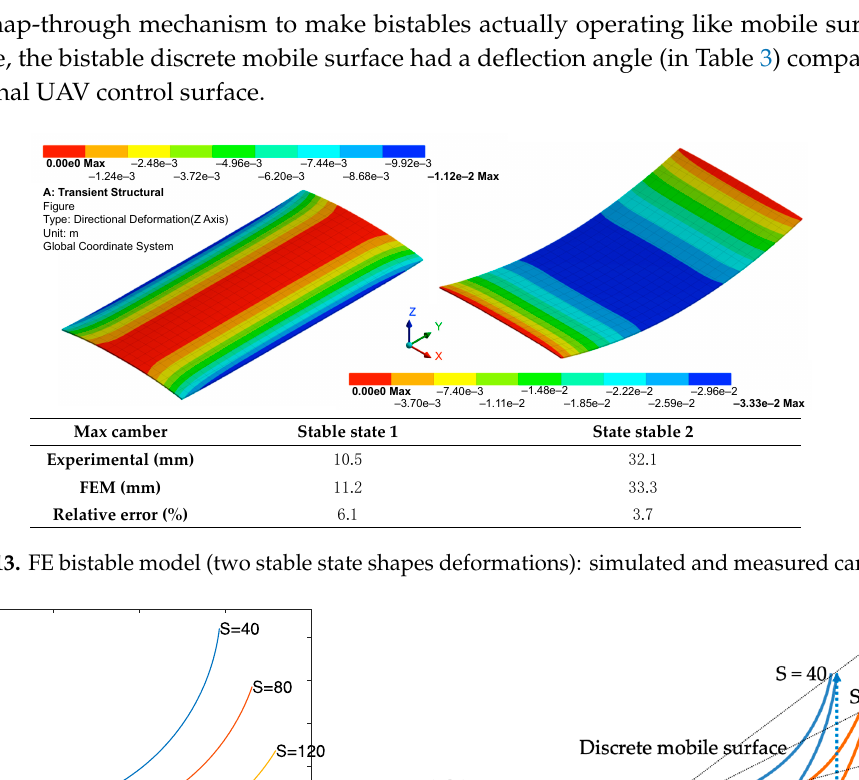
Figure 14. Discrete mobile surface with “lever effect”: ( a ) plate deflection f with different value of S ; and ( b ) airfoil NACA0011 with different bistable angles δ and deflections f . Table 3. Deflection f and δ for each values of S